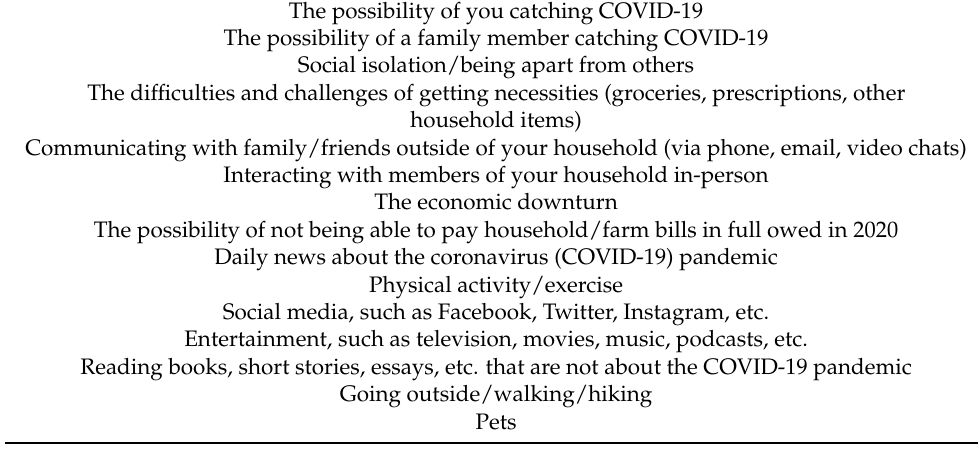
Table 1. Complete list of individual items measuring COVID-19 specific factors, from Mental Health Research Canada’s Mental Health During COVID-19 Outbreak polls